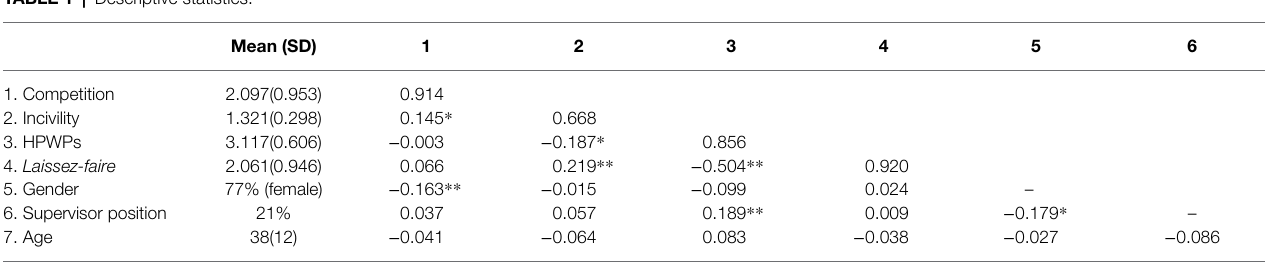
TABLE 1 | Descriptive statistics.